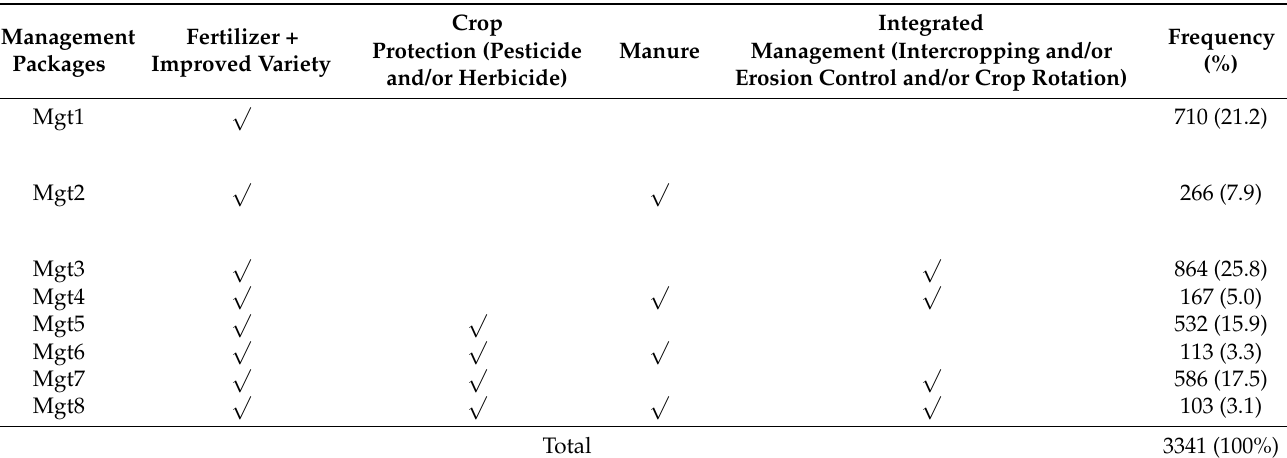
Table 2. Management packages